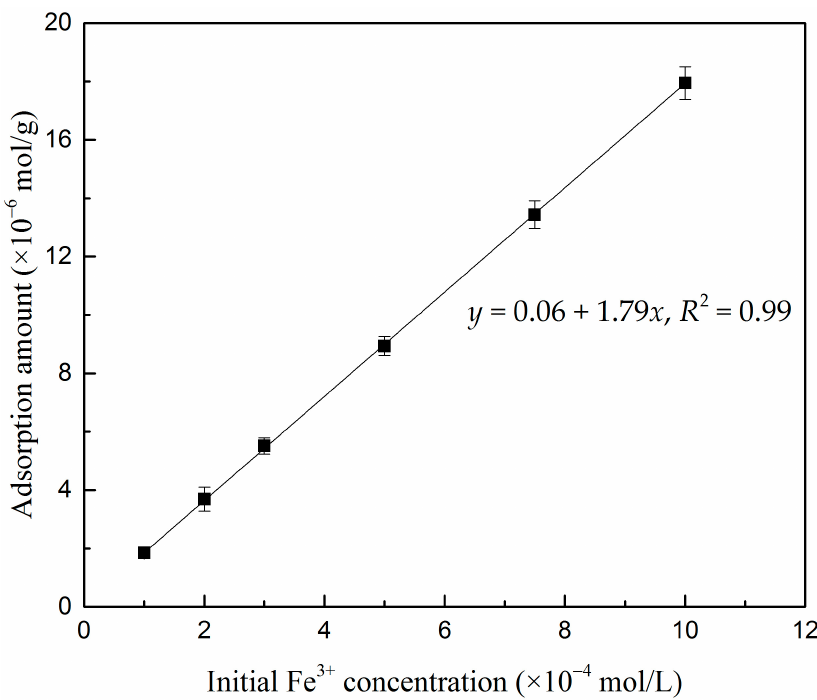
Figure 4. Adsorption amount of Fe 3+ on digenite surface as a function of the initial Fe 3+ concentration at pH 7.0.